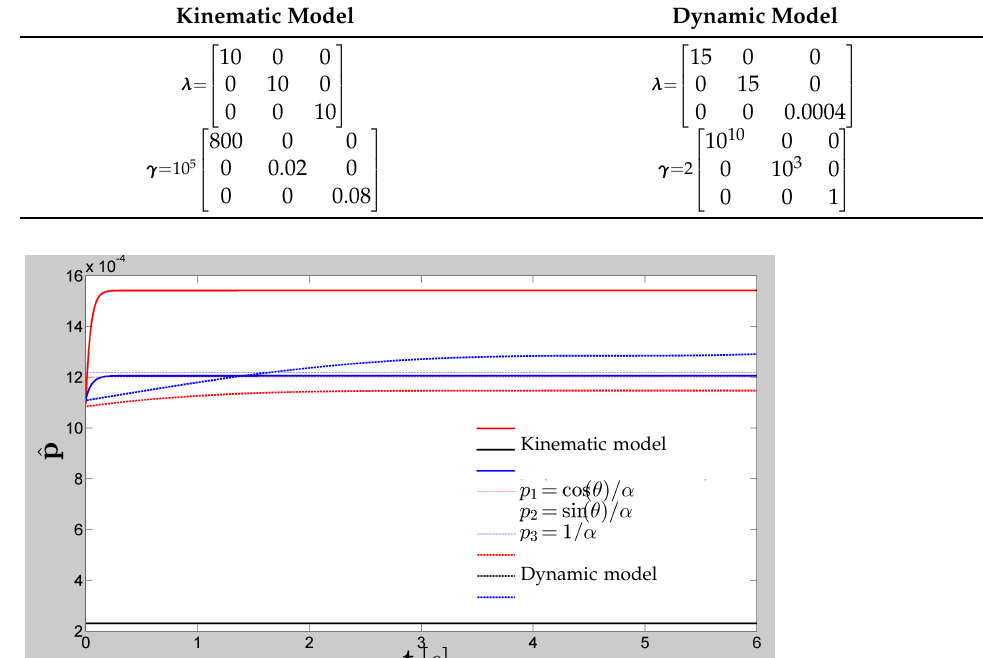
Table 1. The gains for the positioning task.